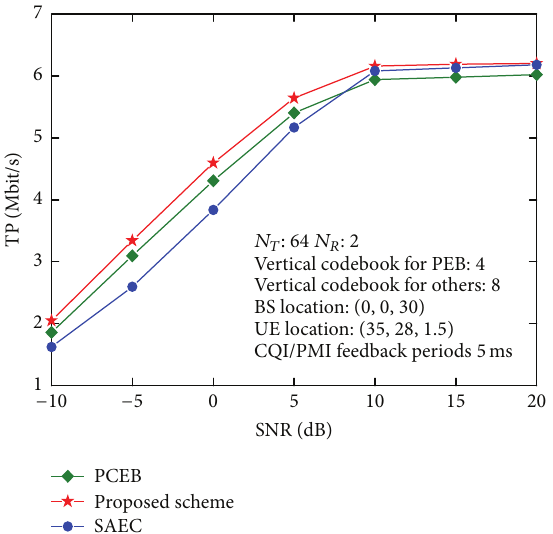
Figure 12: The throughput comparison when UE is distributed in a 120 ∘